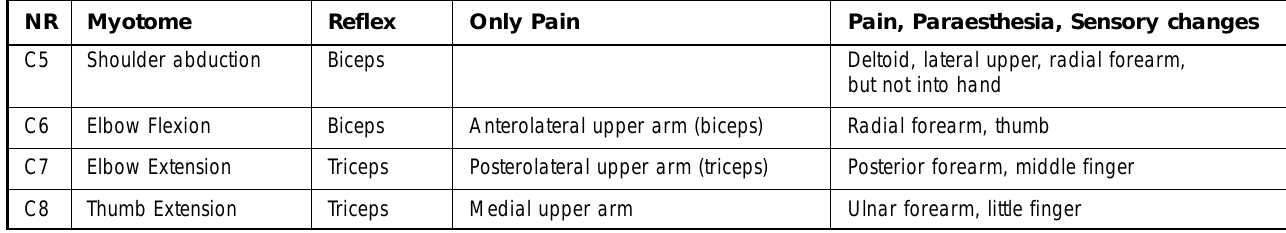
Table 1: Criteria for determining suggested level(s) of NR involvement regarding myotomes, reflexes, pattern(s) of sensory disturbances and pain pattern(s) (Compiled from: Keegan & Garrett 1948; Maitland 1993; Nitta et al 1993; Butler